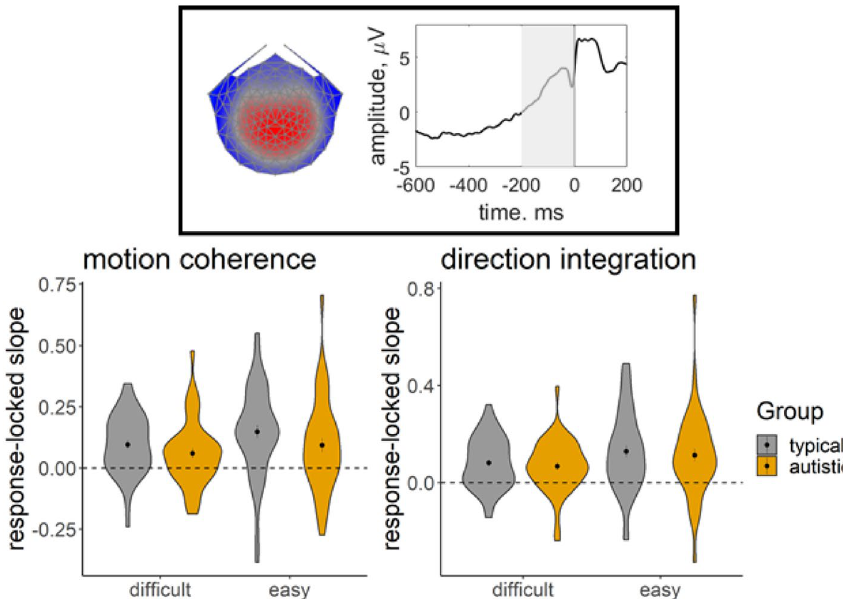
Figure 6. EEG slope measure extracted for inclusion in the joint model. Violin plots showing the kernel probability density for the EEG slope measure extracted for inclusion in the joint model for each group (typically developing: grey; autistic: orange) for each difficulty level. The coloured ‘violins’ reflect the distribution of each group’s data points. The extracted measure was the slope of a linear regression line fitted to each participant’s deconvolved (with regularisation) response-locked waveform, from 200 ms prior to the response to the point of the response (i.e., 0 ms; see shaded area of schematic response-locked waveform in inset). The dotted line reflects a flat slope. Dots and vertical lines represent the group mean and ± 1